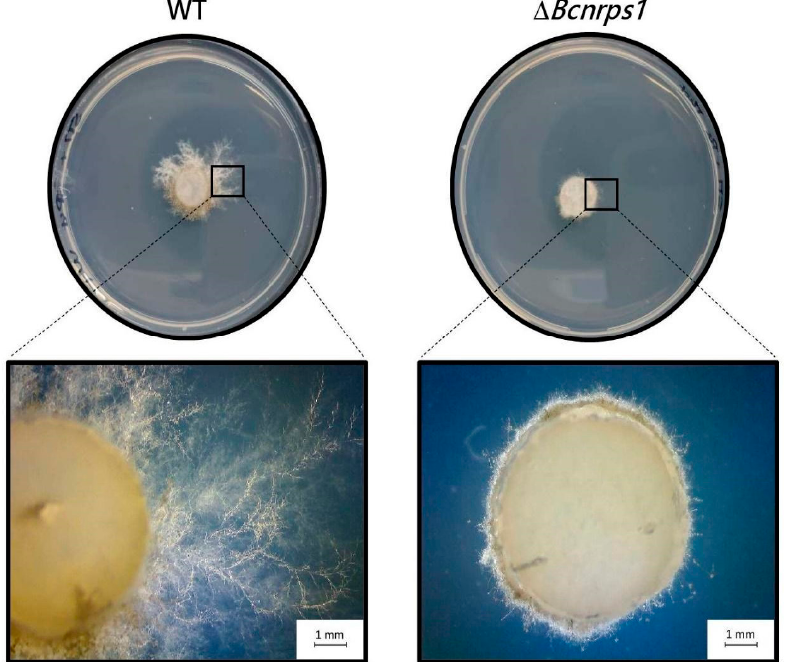
Figure 8. Growth of B. cinerea strain (WT) and ∆ Bcnrps 1 strain in SM culture medium supplemented with 1 µ g/mL pyrimethanil at 3 dpi. Visual examination of the inoculation zone of the strains by observation under binocular microscope.